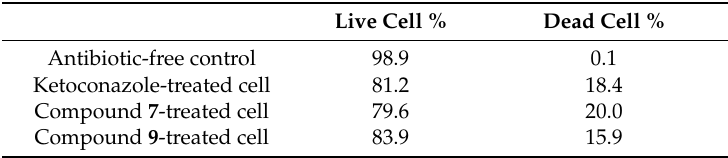
Figure 3. Effects of compounds 1 – 10 on cell viability. Bacteria and yeasts were treated for 24 h with compounds. Data are expressed as a percentage of untreated controls (which is set at 100%). Reference drugs are chloramphenicol for bacteria and ketoconazole for yeasts. * p ≤ 0.05. The results represent the mean ± SD of three independent experiments. Table 2. The percentage of live and dead cells after incubation with the compounds.